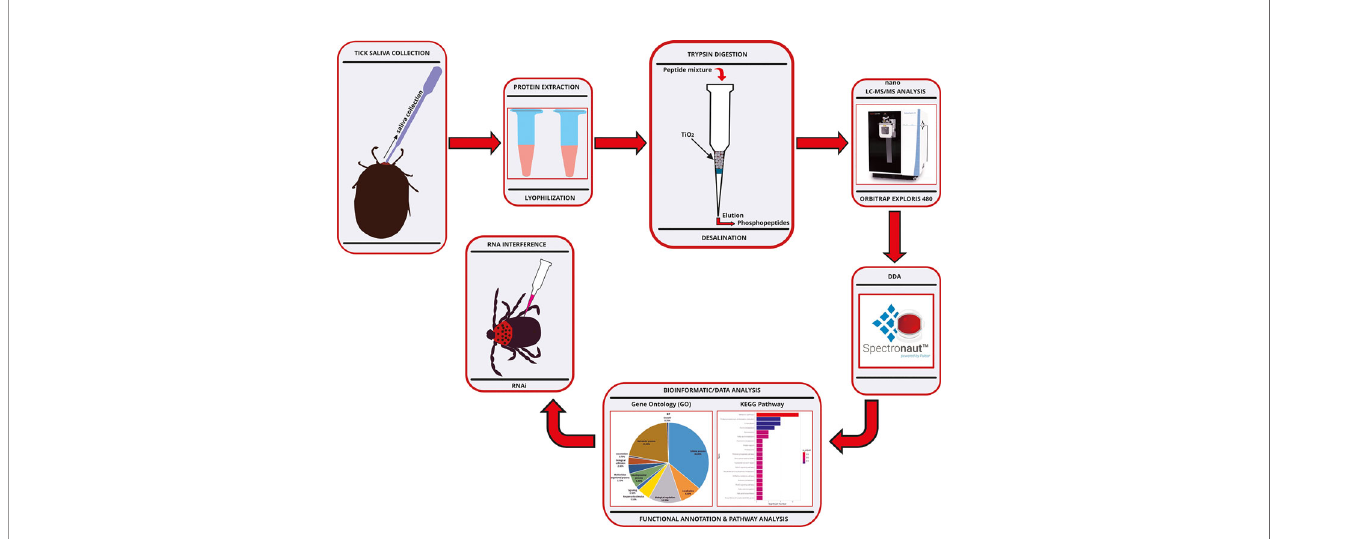
FIGURE 1 | Experimental work fl ow chart for the phosphoproteomic analysis of the salivary proteins of Haemaphysalis longicornis tick. RP-HPLC, Reversed Phase- High Performance Liquid Chromatography; DIA, Data-Independent